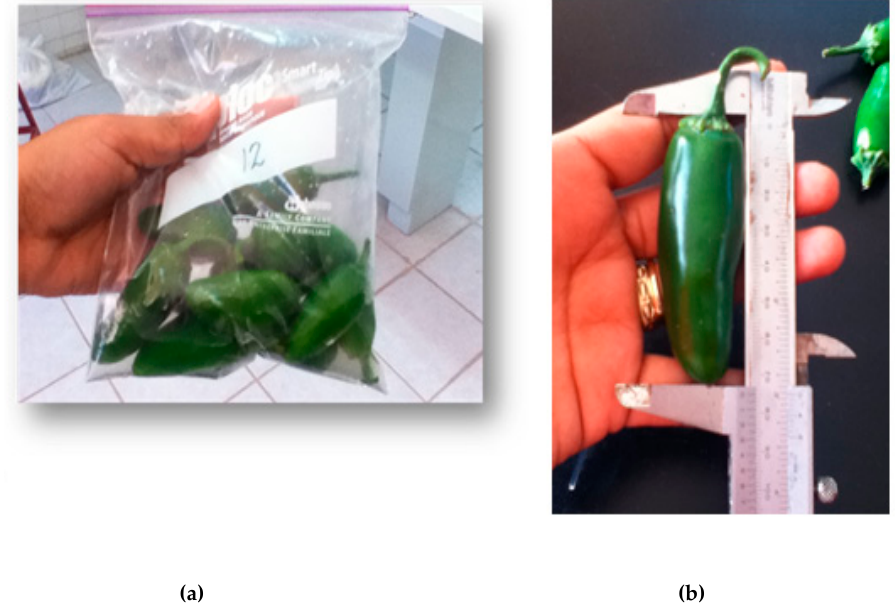
Figure 2. Sampling ( a ) and measurement ( b ) of fruits for the yield and size-quality classification.